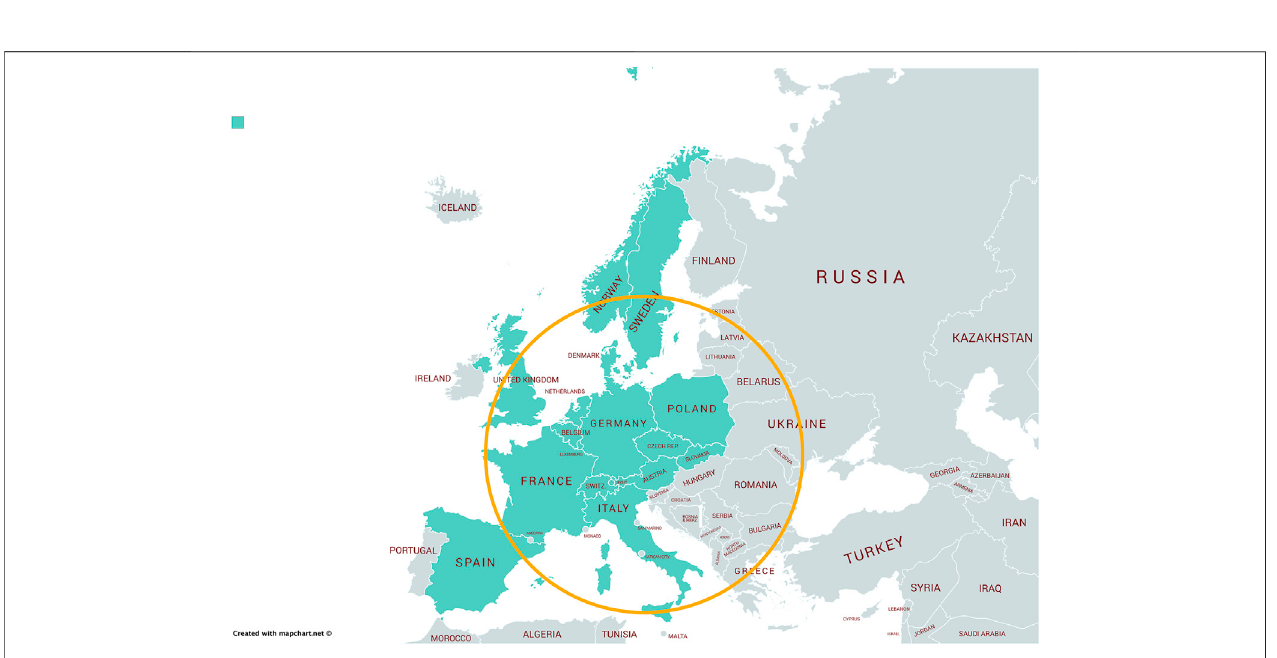
FIGURE2| Depthdosepro fi lesinwater (A) andtreatmentplans (B) [6]comparingphotons,deliveredwiththemostadvancedintensitymodulatedX-rayRT(IMXT), and state-of-the-art scanned protons and C-12 ions, showing the increased tumor-dose conformity of ion therapy due to the characteristic Bragg peak (A) .